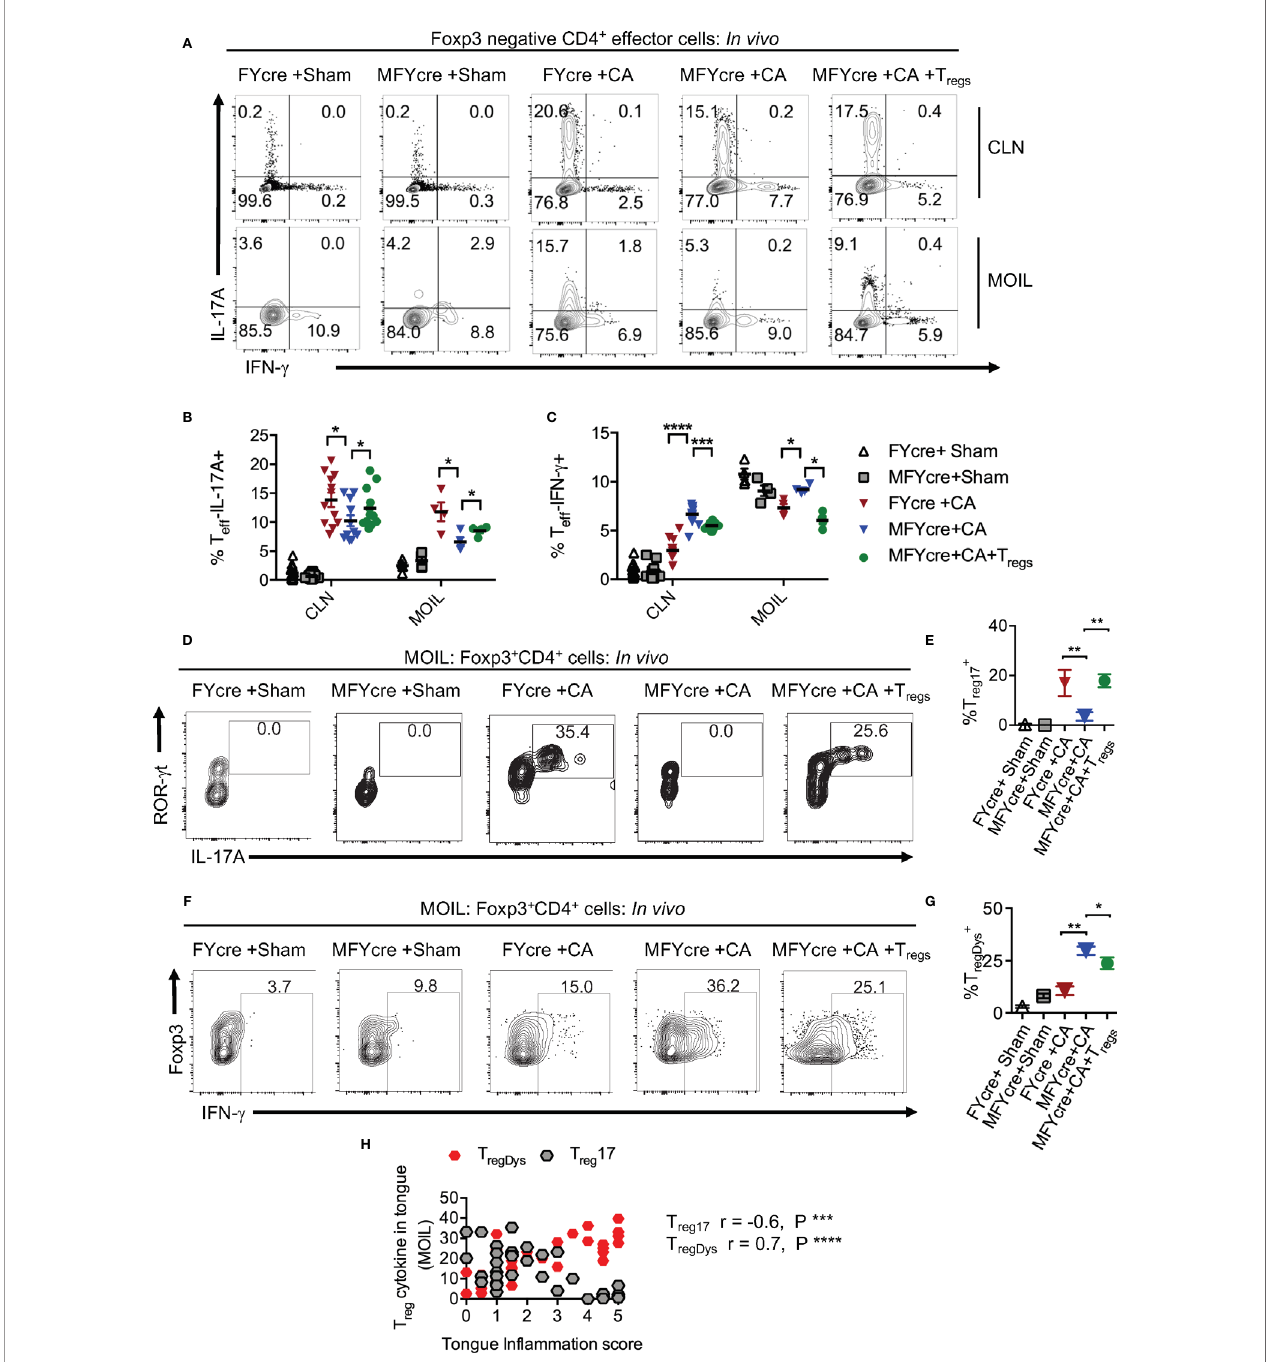
FIGURE 3 | Loss of MyD88 in T regs diminishes IL-17A and increases IFN- g expression in effector cells and Foxp3 + cells in vivo during oropharyngeal candidiasis (OPC) infection. FYcre and MFYcre mice were infected with sham control or CA as in Figure 2 (n= 4 – 6/group). On day 3 after infection, cells from cervical lymph nodes (CLN) and mouse oral intra-epithelial and lamina propria leukocytes (MOIL) were restimulated with PMA-ionomycin to assess intracellular proteins. MOIL cells pooled from 2 mice were used for fl ow cytometric analyses. (A) Flow plots of IL-17A and IFN- g , gated on CD3 + CD4 + Foxp3 - effector (T eff ) cells. Statistical analyses of T eff IL-17A + (B) , and T eff IFN- g + (C) . Flow plots of ROR- g t and IL-17A (D) , Foxp3 and IFN- g , (F) gated on CD3 + CD4 + Foxp3 + T reg cells, and statistical analyses of the proportion of ROR- g t + IL-17A + T regs (% T reg17 ) (E) , and T reg IFN- g + (% T regDys ) (G) , in different groups are shown. For statistical analyses, data are pooled from two experiments. Each data point represents one mouse in CLN and 2 mice in MOIL. Mean values ± SEM are plotted. (H) Correlation curve was plotted using values from tongue in fl ammation score, %MOIL T reg 17 and %MOIL T regDys in infected mouse groups. These data represent three independent experiments showing similar results. *P < 0.05, ***P < 0.005, ***P < 0.0005, ****P <